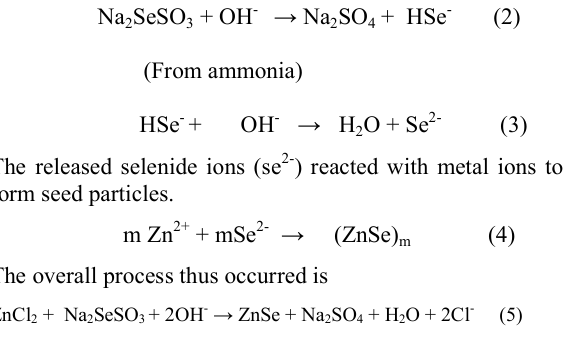
Figure 2 represents XRD of four different ZnSe– PVA composite films (ICSD-II 067791) . The